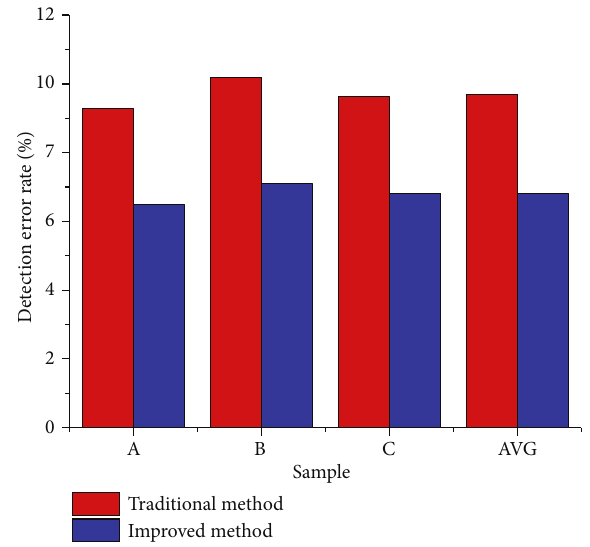
Figure 4: Comparison of detection error rate before and after